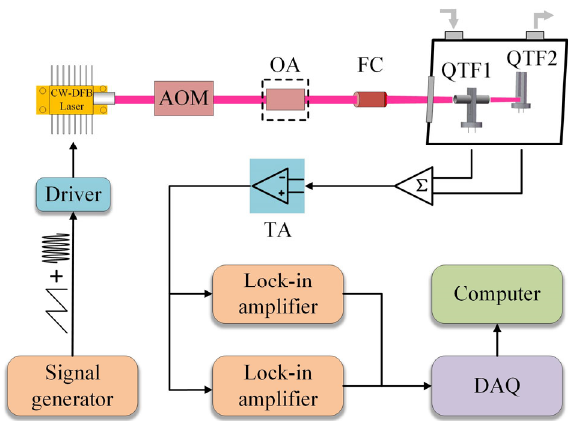
Figure 1. Schematic diagram of the experimental setup. AOM: acousto-optic modulator; OA: fiber optic attenuator; and FC: fiber collimator.